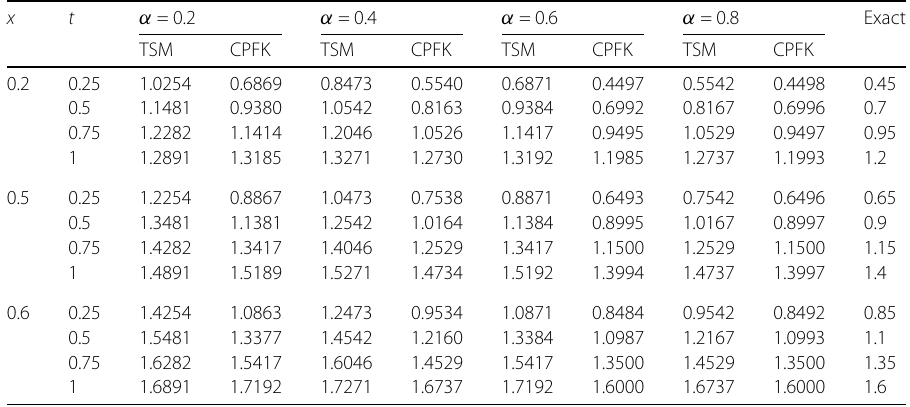
Table 1 The comparative numerical value of the present method with the method [7] for Example